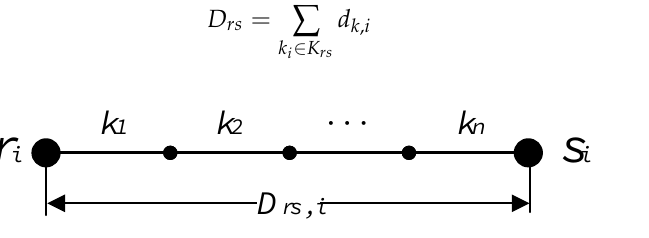
Figure 4. Schematic of an origin-destination (OD) pair.